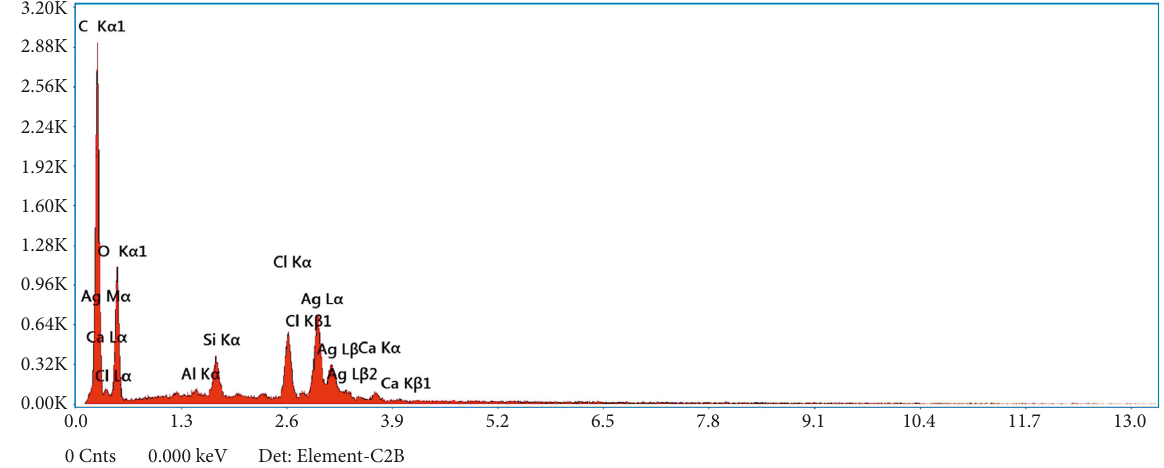
Figure 7: EDX spectra of Ag-NPs.